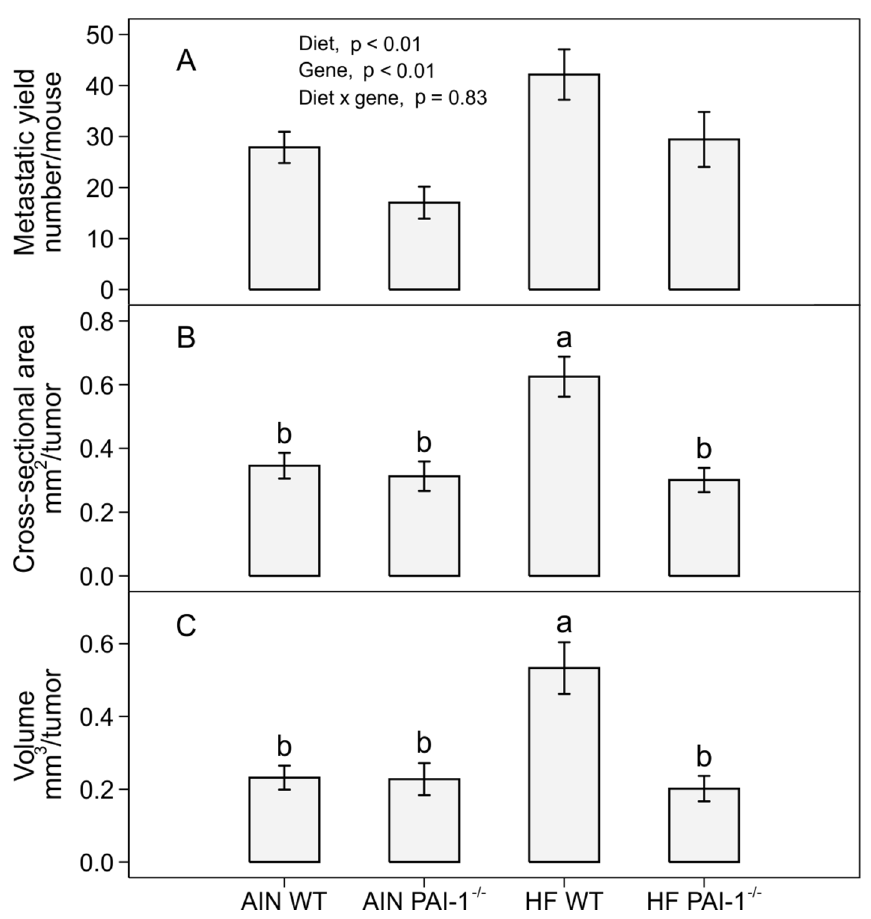
Figure 2. The number ( a ), cross-sectional area ( b ) and volume ( c ) of pulmonary metastases in PAI-1 2 / 2 and wild-type mice fed the AIN93G or the high-fat diet. Two-way ANOVA and Tukey contrasts were performed to test for differences among the groups. Values (means 6 SEM) with different superscripts are significantly different at p # 0.05 (n=22 per group for PAI-1 2 / 2 mice, n=28 per group for wild-type mice). AIN WT: AIN93G-fed wild-type mice, AIN PAI-1 2 / 2 : AIN93G-fed PAI-1 2 / 2 mice, HF WT: high-fat fed wild-type mice, HF PAI-1 2 / 2 : high-fat fed PAI-1 2 / 2 mice. (Table 4). The high-fat diet, compared to the AIN93G diet, increased plasma insulin by 111% (high-fat vs. AIN93G: p , 0.01) and glucose by 23% (high-fat vs. AIN93G: p , 0.01) (Table 4). Deficiency in PAI-1 increased plasma insulin by 15% (PAI-1 2 / 2 vs. wild-type: p =0.01, Table 4). There was no significant